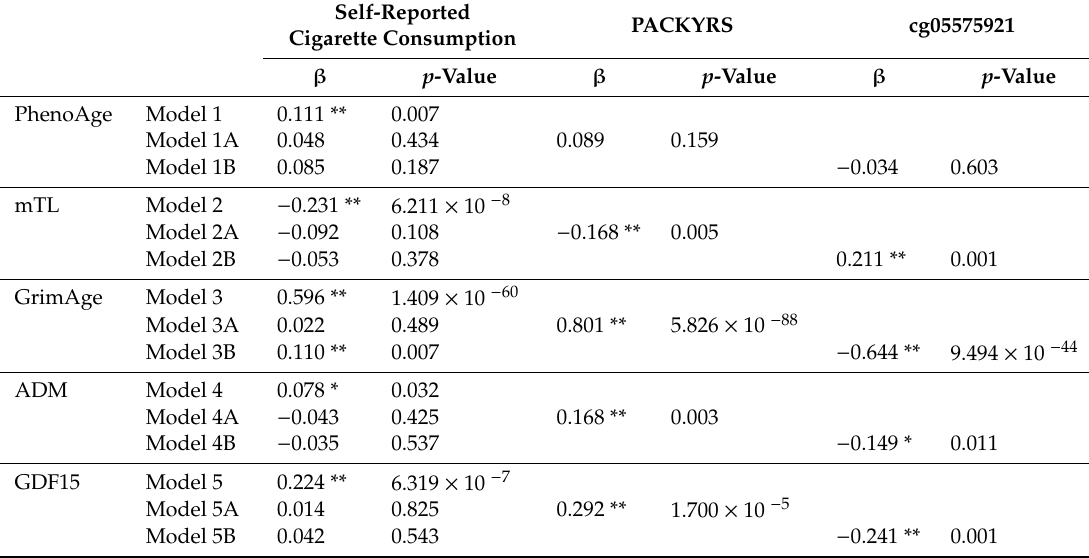
Table 2. Regression models depicting the e ff ects of cigarette use on DNA methylation-based aging indices through DNAm-based estimates of smoking, controlling for BMI, gender, and cell-types (Monocytes, natural killer, CD8 + T, CD4 + T, and Bcells) (N =